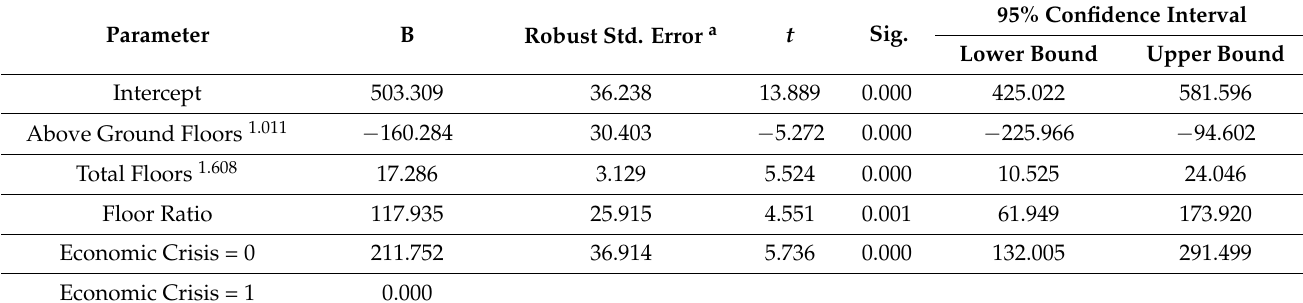
Table 7. Regression models for the initial unit